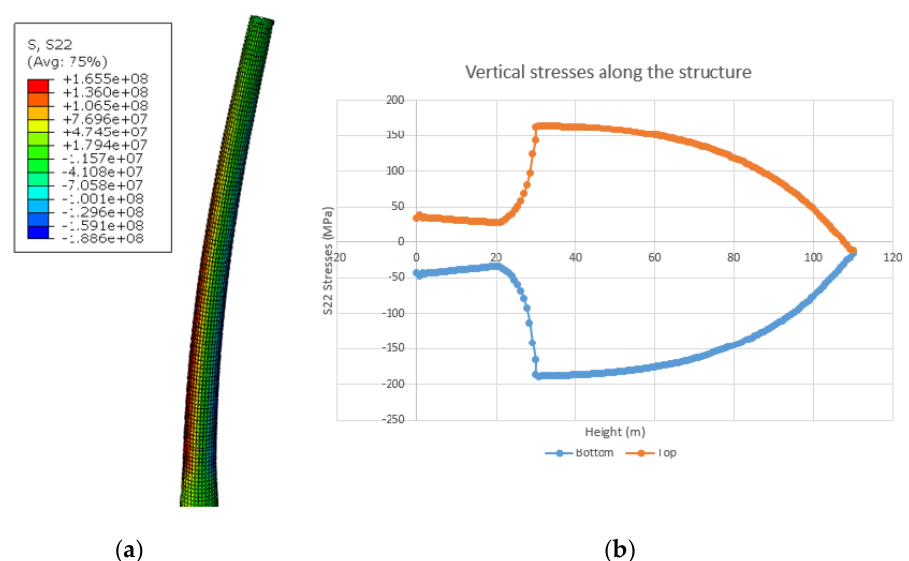
Figure 9. Vertical stresses — Extreme conditions, ( a ) Results of stress analysis, ( b ) Stress map.